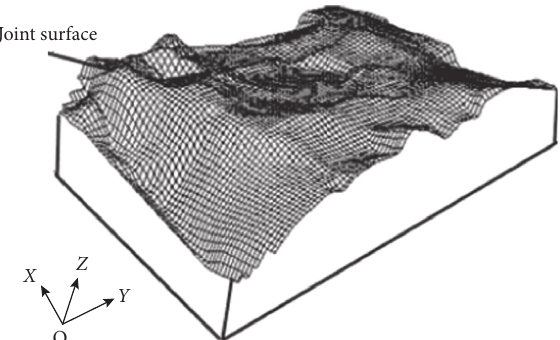
Figure 10: Schematic of the rock joint surface